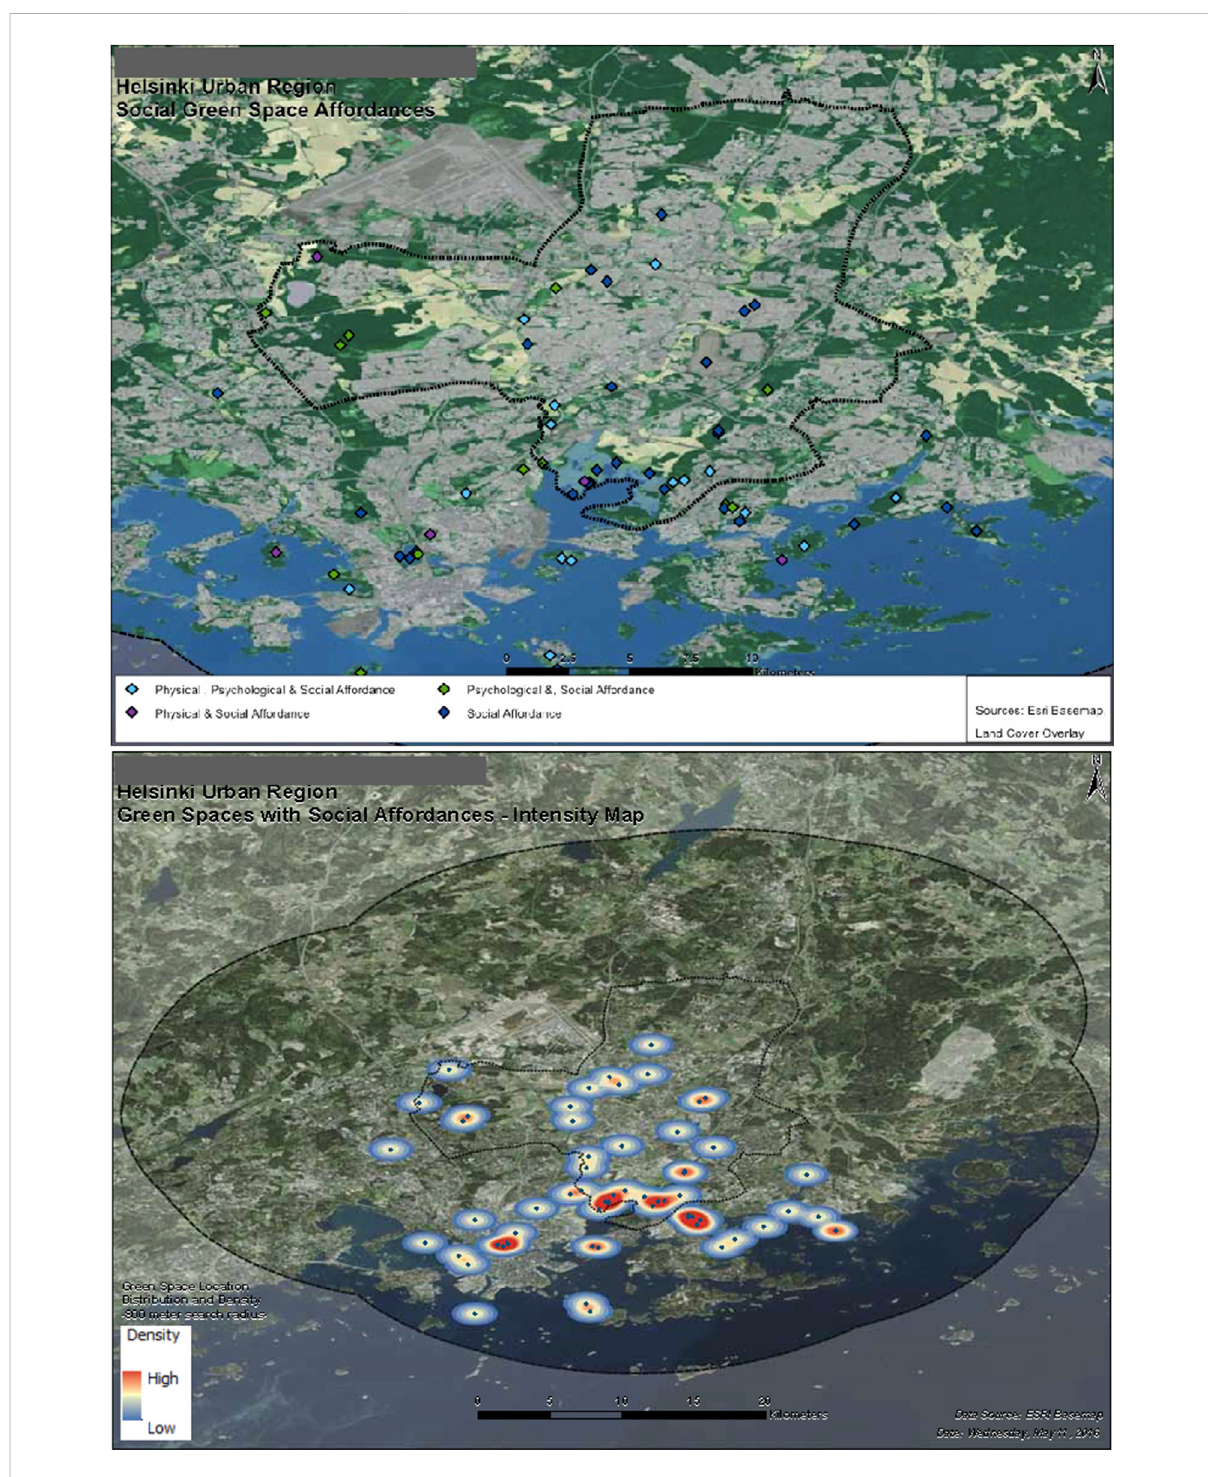
FIGURE 6 Social human wellbeing affordance locations and intensity map. Source: